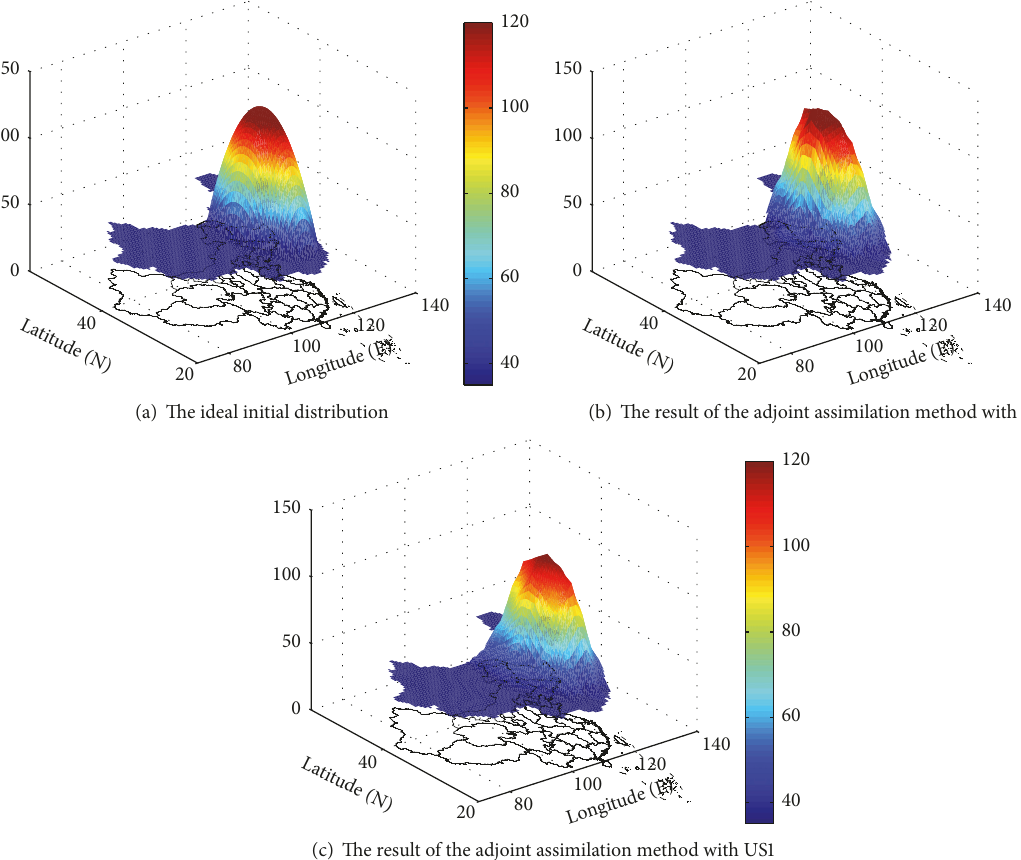
Figure 3: The 3D images of the results inverted by the adjoint assimilation method with different